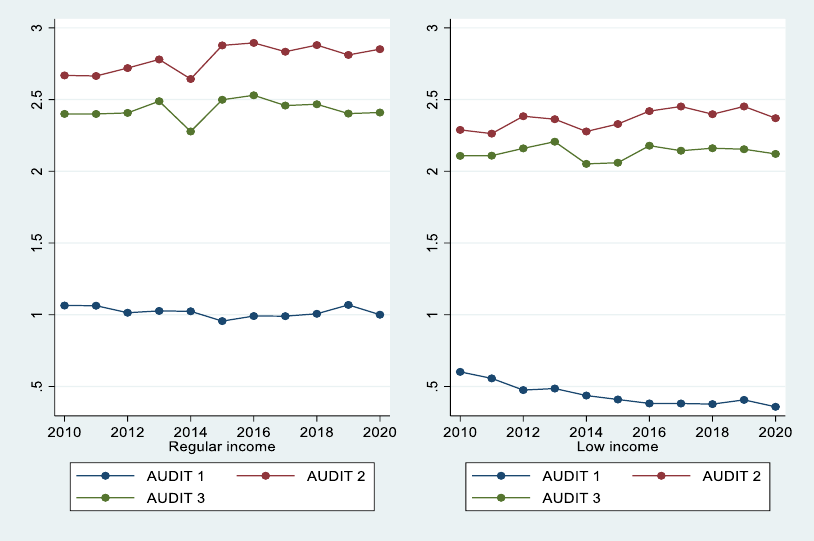
Figure 4. Trends in the three AUDIT items in regular- vs. low-income households from 2010 to 2020.